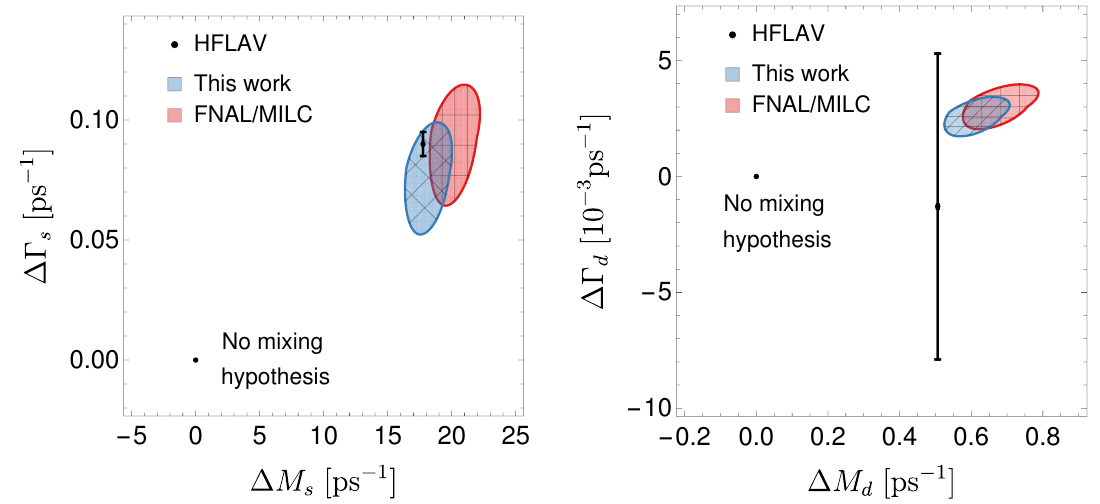
Figure 8 . Comparison of our predictions for the mass and decay rate di(cid:11)erence in the B s (left) and B d (right) system with the present experimental averages (error bars). We also show the results obtained with the lattice results of [5] for f 2 in appendix B for the other input parameters. The PS mass scheme for the bottom quarks has been used in both cases.